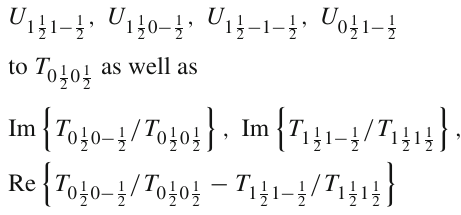
2% originating from the uncertainty on the beam polarization is present ( 1 ) } , Re { t ( 2 ) } , and Re { u ( 2 ) } , but also not shown. for the ratios Im { t λ V λ γ λ V λ γ λ V λ γ The amplitude ratios are ordered according to the classes proposed in Refs. [17,38]. The red , filled circles correspond to the extracted ampli- tude ratios and the blue , open triangles ( squares ) represent the result of the GK model calculation using the positive (negative) sign of the π − ρ transition form